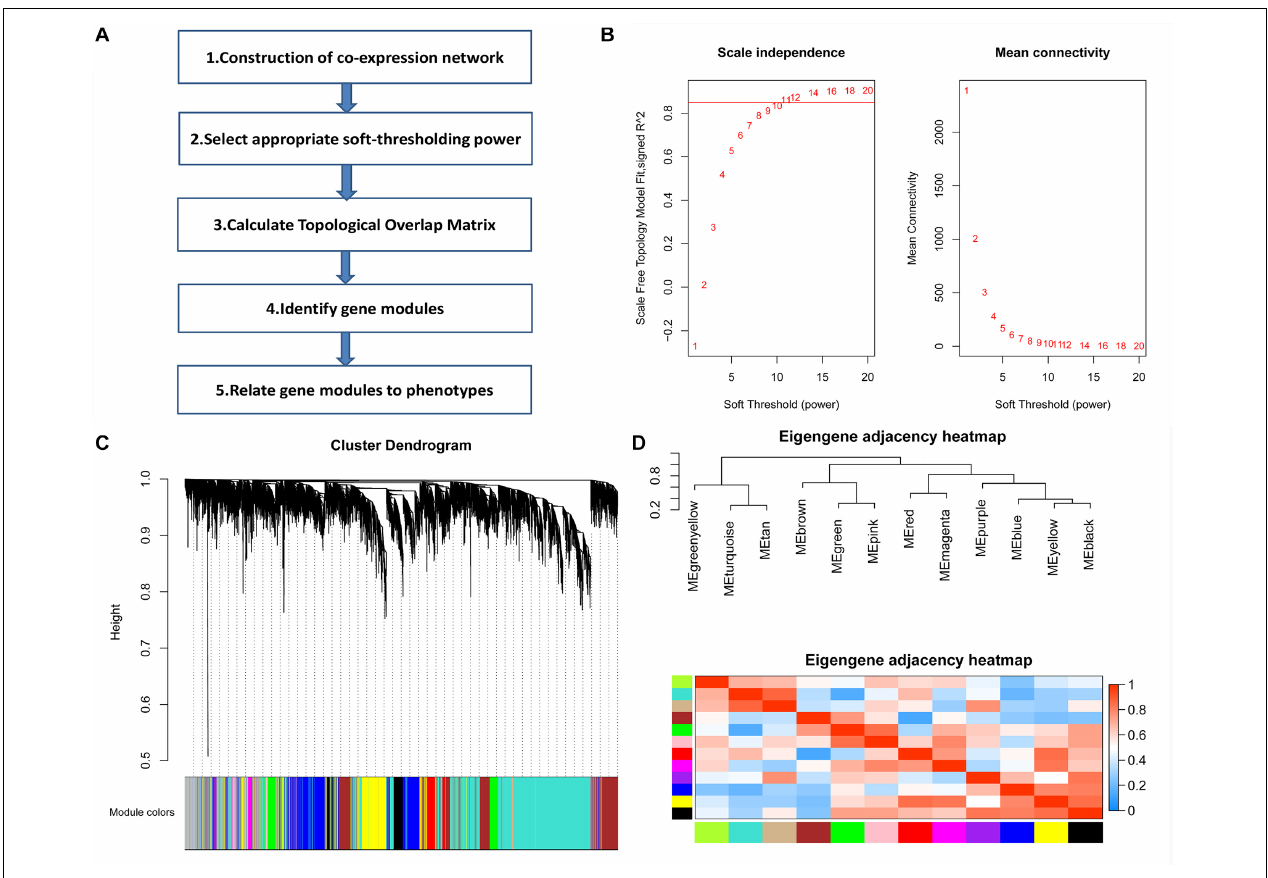
FIGURE 1 | Weighted gene coexpression network analysis (WGCNA). (A) The schematic of WGCNA. (B) Determination of the soft threshold. Analysis of the scale-free topology fitting index R 2 (left) and mean connectivity (right) for various soft threshold powers. The red line in the left panel indicates R 2 = 0.85. (C) Clustering diagram showing 12 modules represented by different colors. (D) Clustering tree of module eigengenes and the heatmap of the correlation between any two module eigengenes.